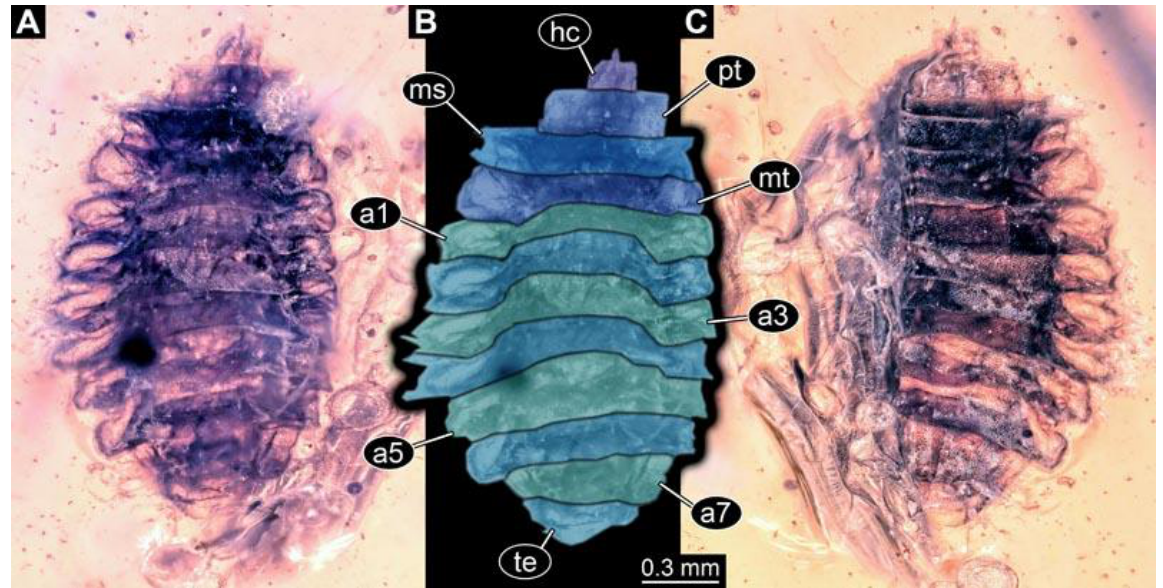
Figure 19. Fossil larva of morphotype 7, specimen PED 1346. ( A ). Ventral view. ( B ). Colour-marked. ( C ). Dorsal view. Abbreviations: a1 – a7 = abdomen units 1 – 7; hc = head capsule; ms = mesothorax; mt = metathorax; pt = prothorax; te = trunk end. (117) PED 0723: Specimen oblique in the amber piece (Figure 7C). Head capsule missing. Dark pigmentation on trunk. Surface structure apparent. Some ventral spine-like setae visible. No measurements could be recorded due to orientation of the specimen. (118) PED 1109: Specimen accessible in dorsal and ventral view, better visible in dorsal view (Figure 10O). Bubbles conceal parts of specimen. Surface structure apparent. Head capsule largely concealed by blurry amber. Ventral spine-like setae well developed. Dimensions: body length 2.06 mm, body width 0.94 mm, head capsule length 0.09 mm,